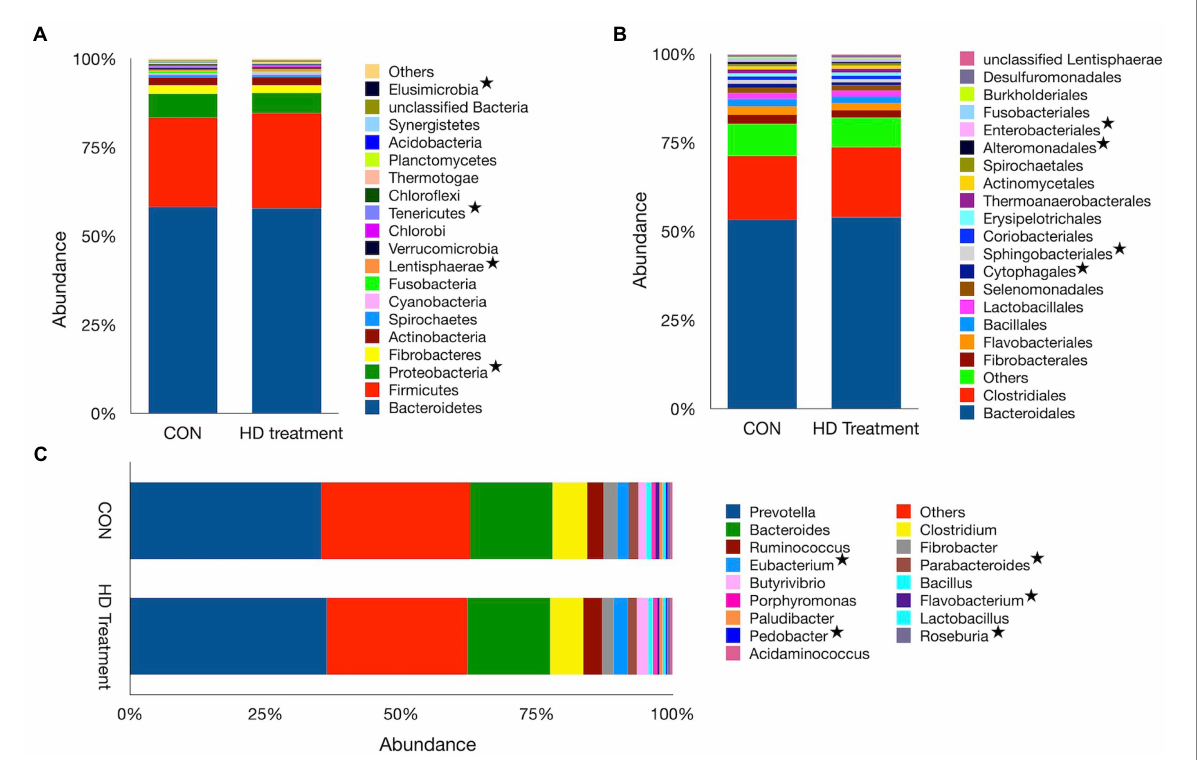
FIGURE 2 Bacterial profiles at different phylogenetic levels observed in the CON and HD treatment groups. The relative abundances of bacterial taxa at the phylum (A) , order (B) , and genus (C) levels are represented by bar plots. The category “Others” represents taxa with a relative abundance of <1%. Asterisks denote taxa that significantly differ in abundance between the CON and the HD treatment